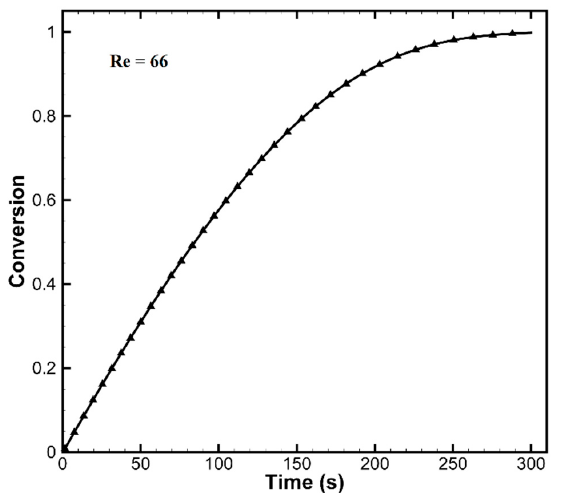
Figure 14. The overall conversion profile in the packed bed over time.